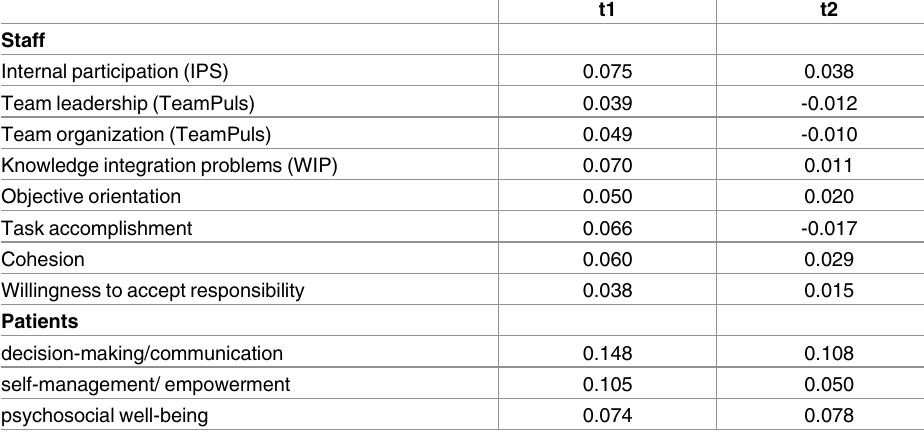
Table 4. ICC for independent variables for staff and